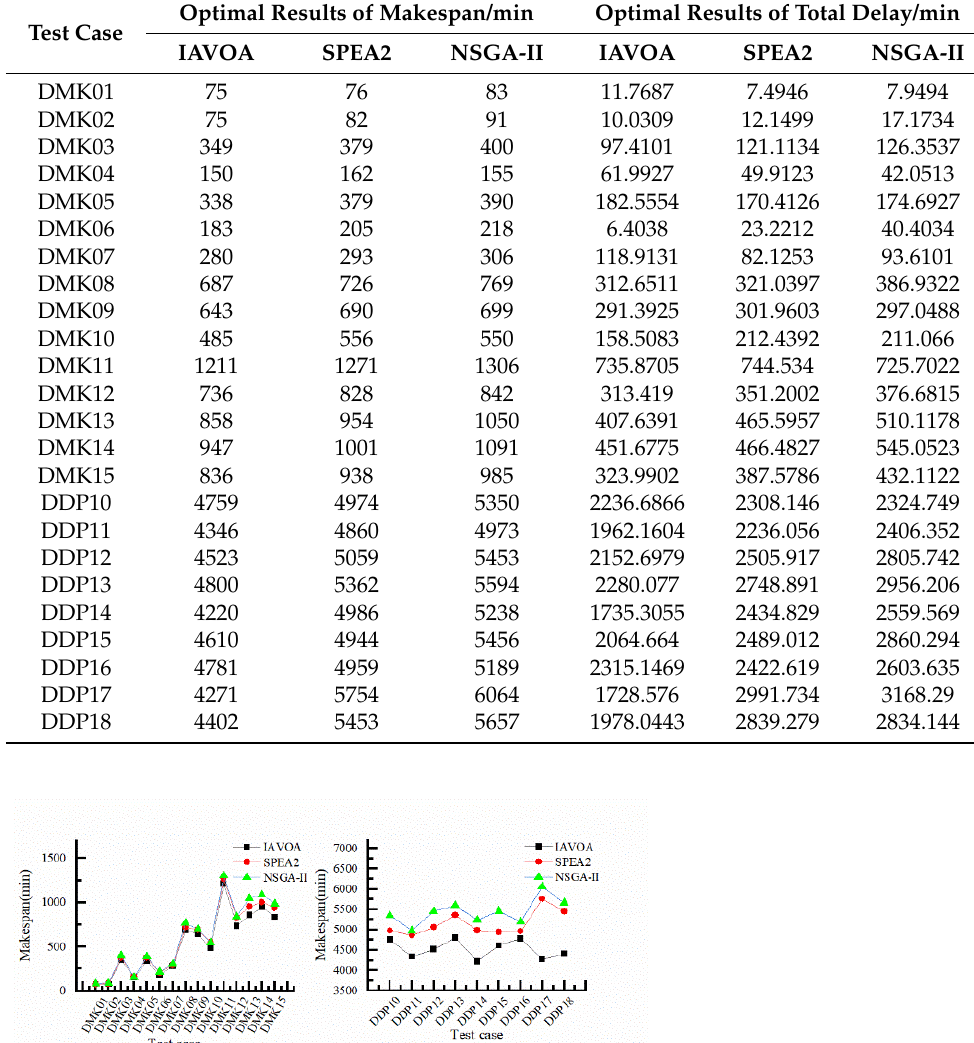
Table 7. Objective function values for the test cases solved with the three algorithms.